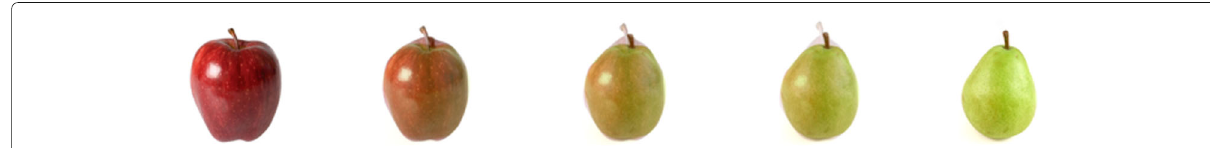
Fig. 8 Morphing result. Morphing from an apple to a pear with a CAC segmentation (initial and final images from [27])